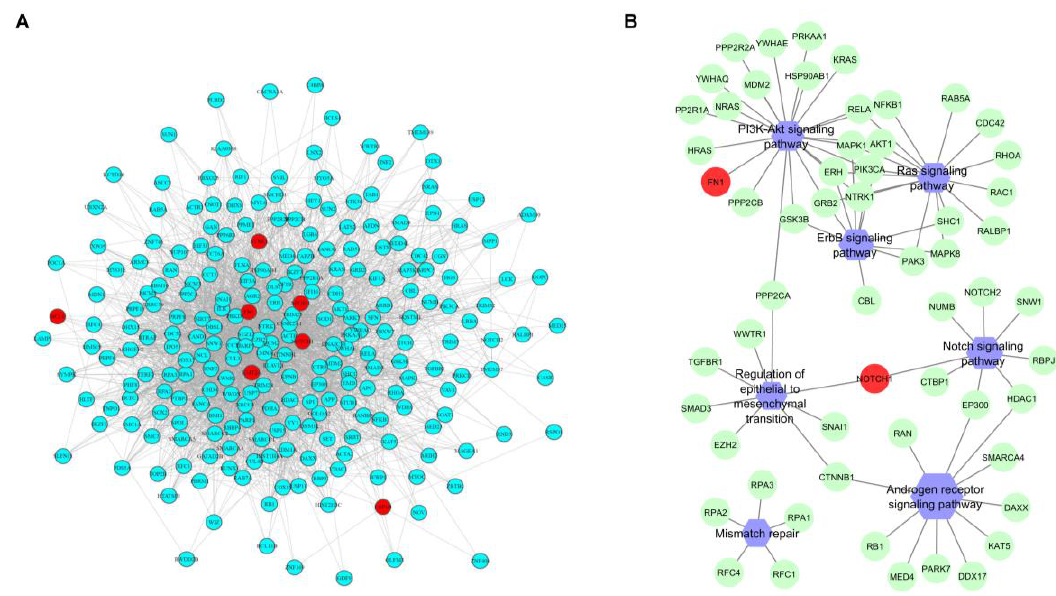
Figure 4. Functional interactions network analysis of co-occurring mutations in pre-NAC samples. ( A ) A network of 246 nodes were obtained starting from co-occurred mutated genes (highlighted in red) using Biogrid protein-protein interaction data. ( B ) Most representative targeted signaling pathway (represented in violet) were obtained from Gene Ontology (GO) and Kyoto Encyclopedia of Genes and Genomes (KEGG) databases.